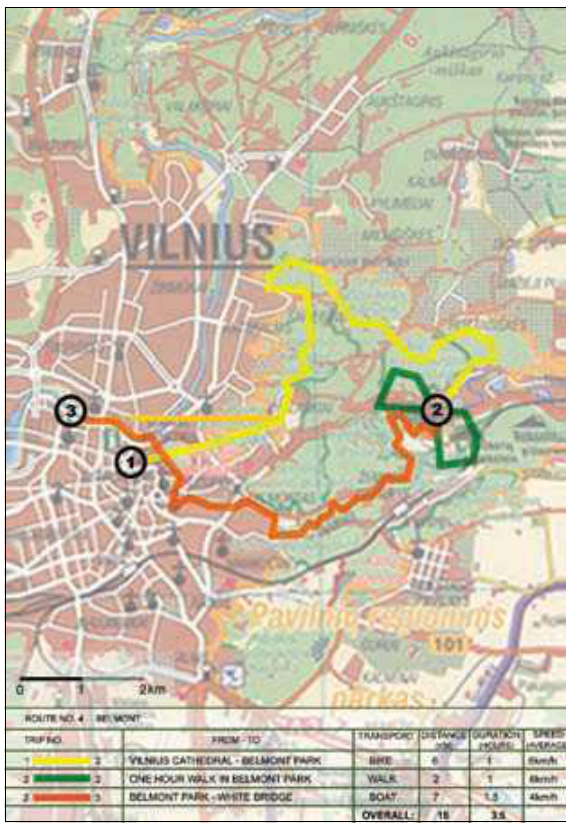
Fig. 3. Planning proposal for sustainable recreation